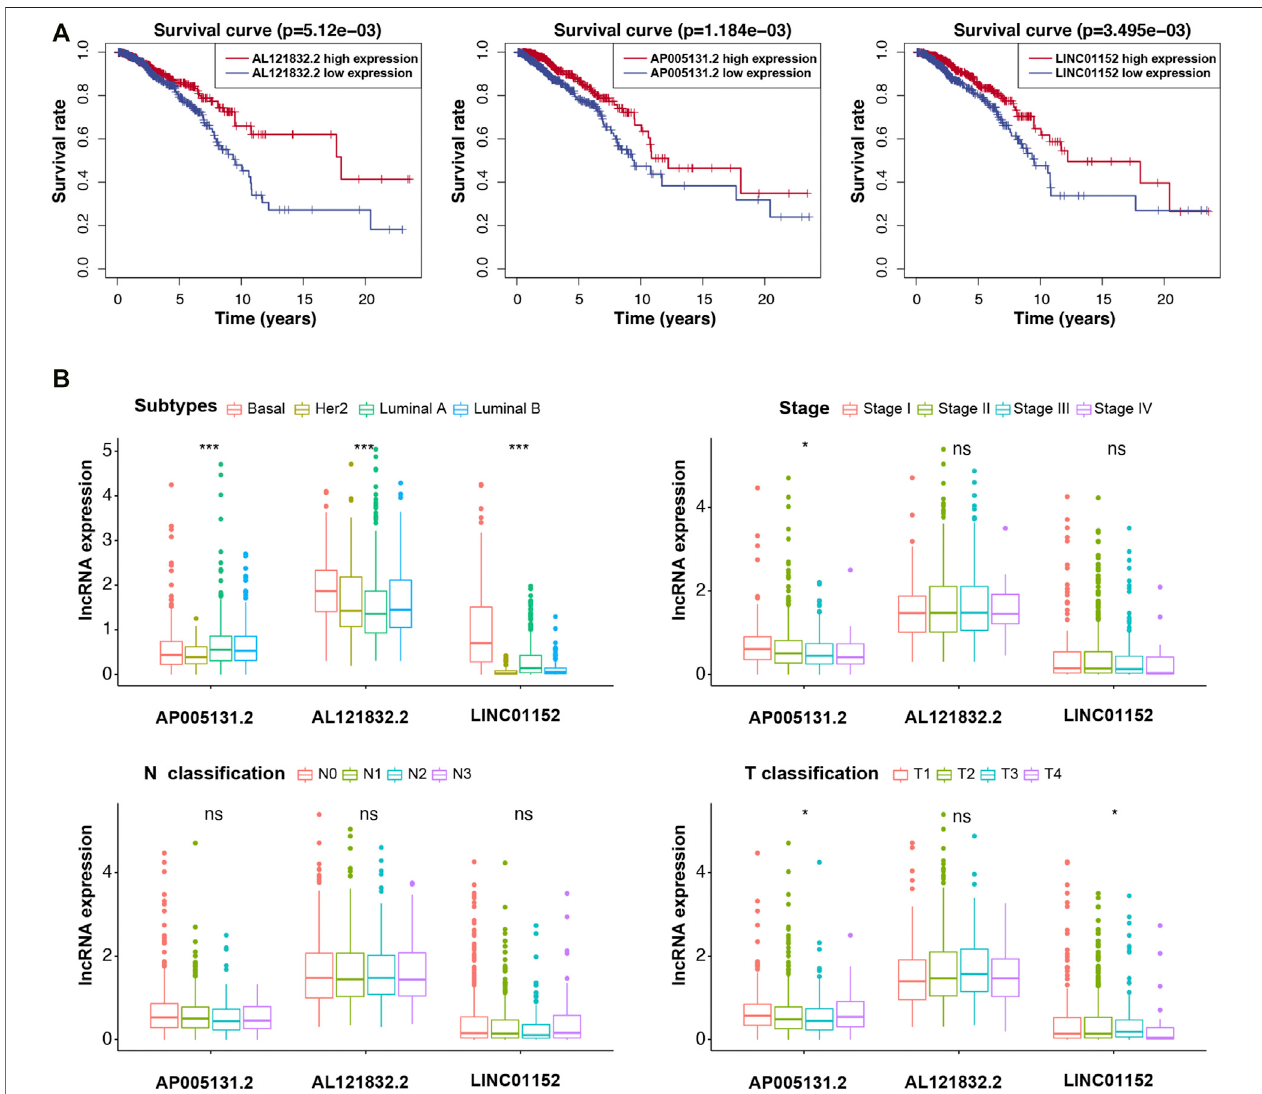
FIGURE4| Survivalanalysisand clinicopathological characteristics ofthethree m5C-lncRNA inhigh- and low-expressiongroups. (A) Kaplan – Meiersurvivalcurve of high- and low-expression groups. (B) Analysis of clinicopathological features. (* p < 0.5, *** p < 0.001).